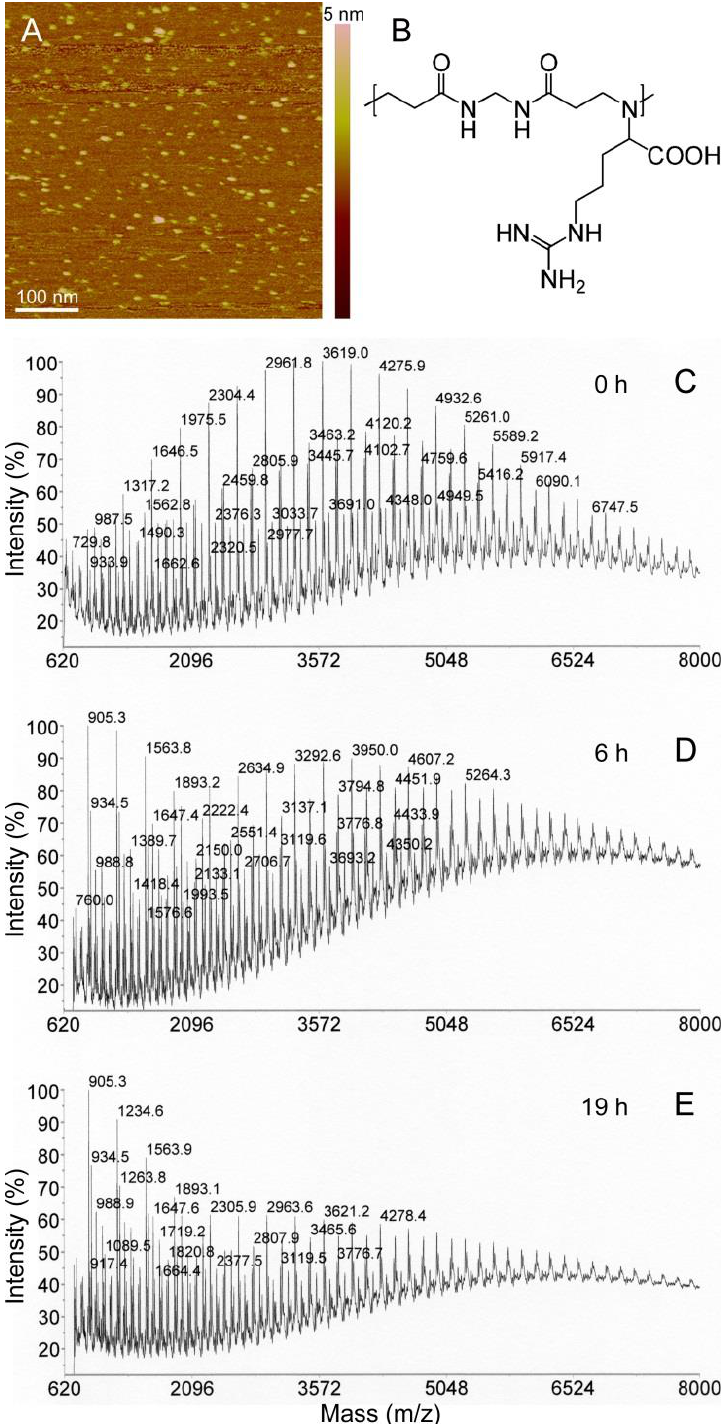
Figure 1. Analysis of PAA stability in GIT conditions. ( A ) AFM image in water of AGMA1. ( B ) Chemical structure of the ARGO7 repeating unit. ( C – E ) MALDI TOF/TOF analysis of the degradation of ARGO7 in simulated fasted-state gastric fluid.